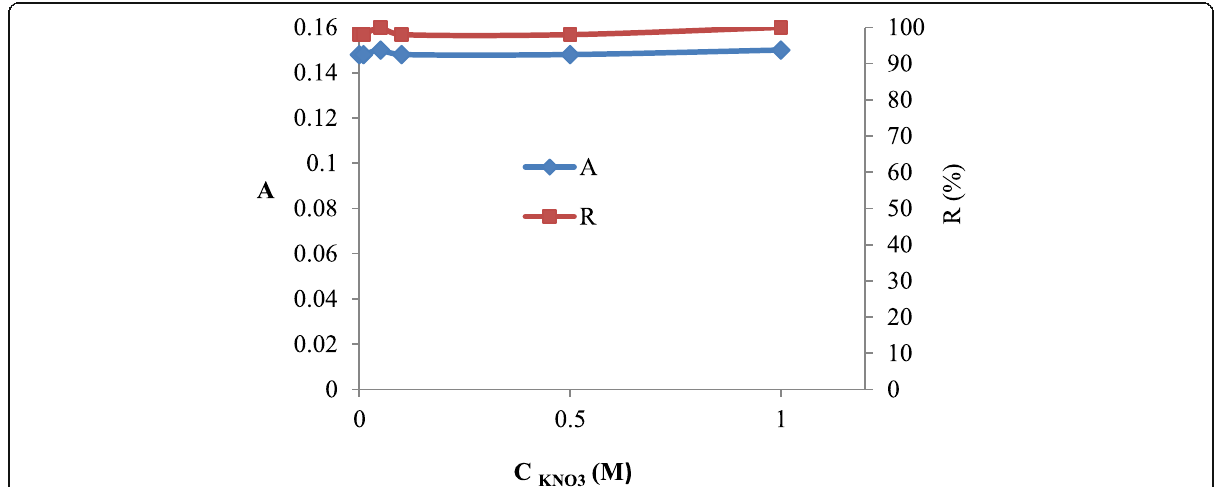
Fig. 9 Effect of ionic strength on the extraction of Cu(II) ions by DLLME method. Conditions: sample volume, 10.0 mL; Cu(II), 50.0 μ g L − 1 , extraction solvent (chloroform) volume, 120 μ L; disperser solvent (acetone) volume, 1.68 mL; diluting solvent (ethanol) volume, 130 μ L; centrifuge time, 5 min (at 5000 rpm)